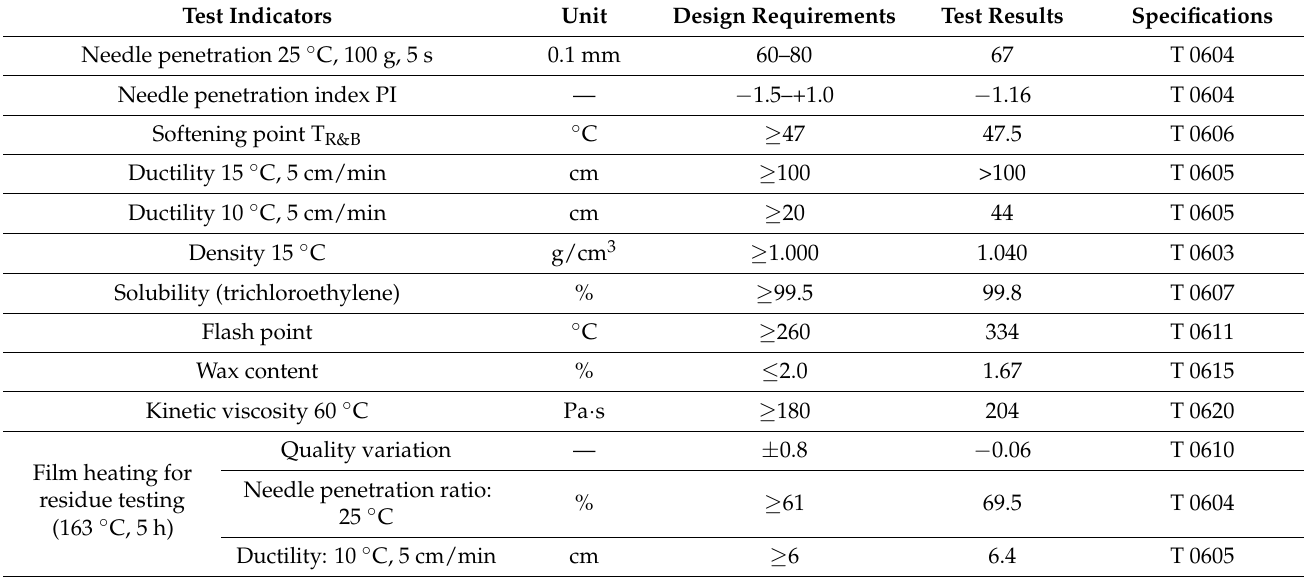
Table 5. A-70 bitumen test results.